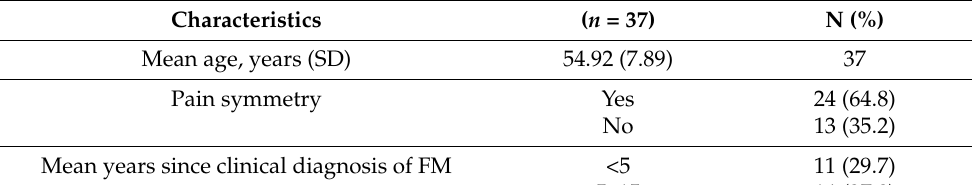
Table 1. Characteristics of the